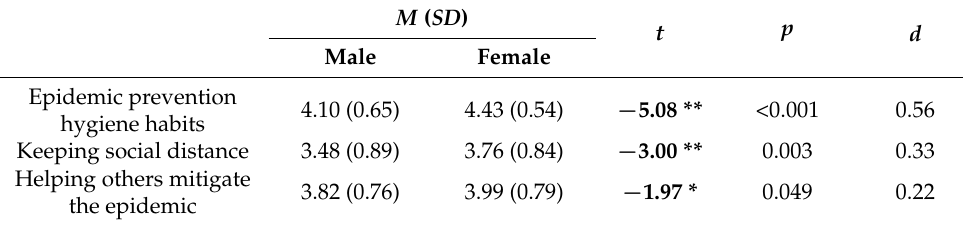
Table 1. t test results of the effect of gender on COVID-19 preventative health behaviors. (df = 338).